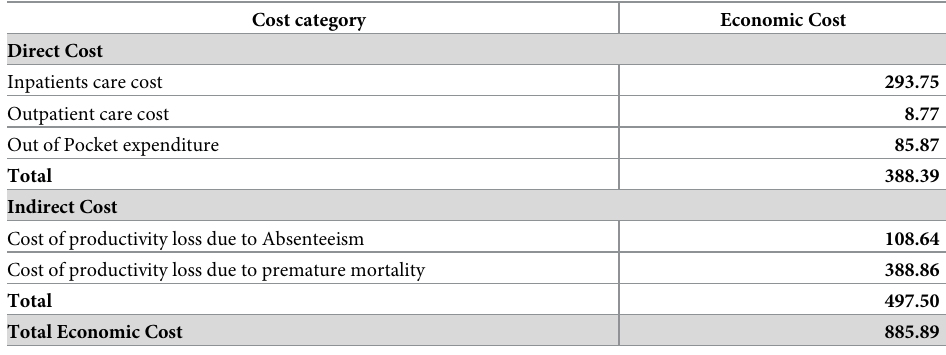
Table 5. Summary of costing analysis in UDS